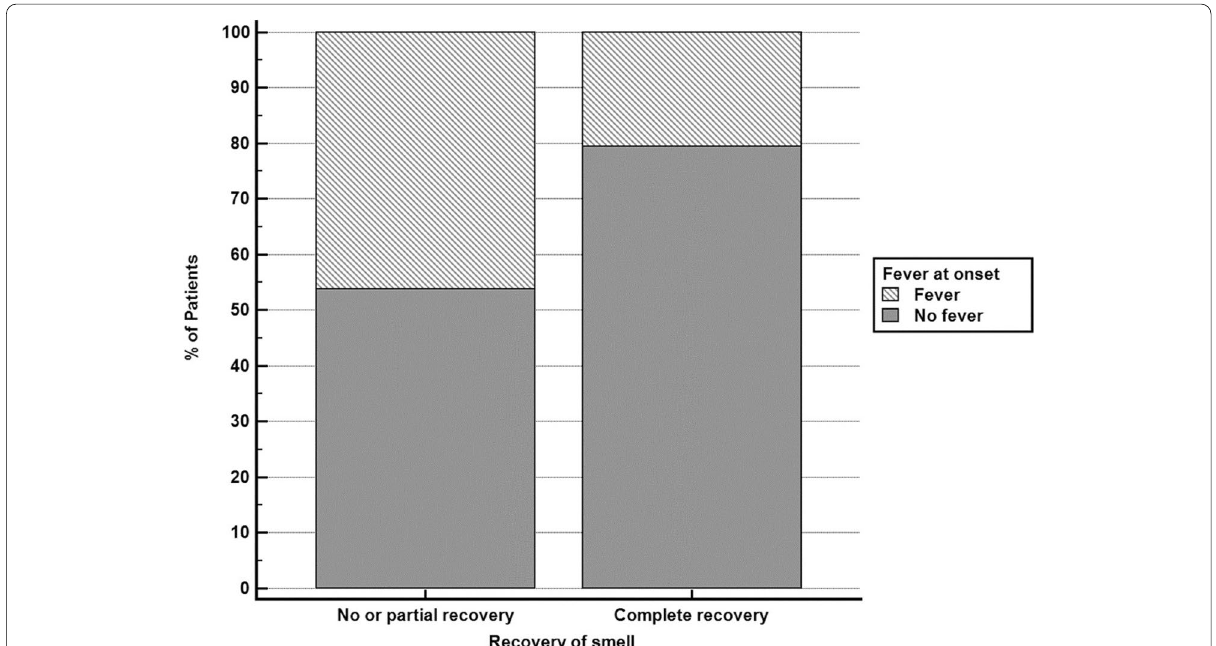
Fig. 4 Relation between fever at onset and occurrence of complete recovery of smell. Fever is associated with lower probability of complete recovery (unadjusted odds ratio